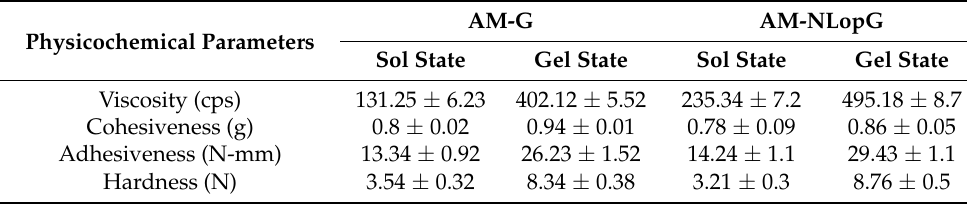
Table 4. Physicochemical characterization of in situ